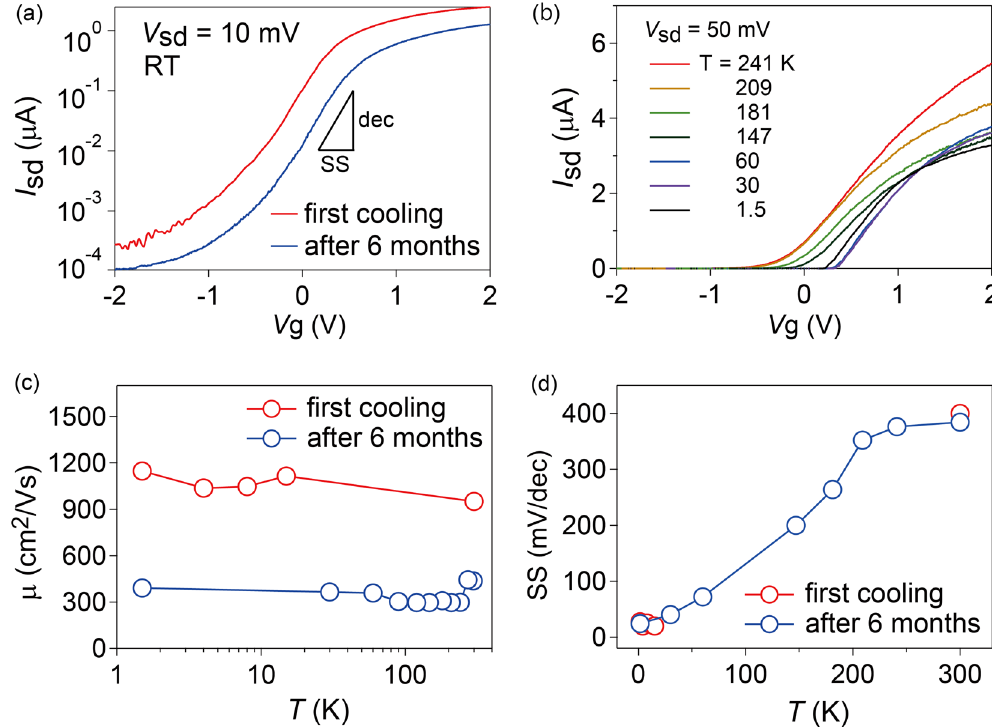
Figure 3. ( a ) Transfer characteristics of the device measured for the first cooling and after several coolings performed over 6 months. The device was stored in ambient conditions for 6 months when not in use. ( b ) Transfer characteristics of the device measured for various temperatures at V sd = 50 mV. ( c ) Field-effect mobility and ( d ) SS values of the device plotted as a function of temperature for the first cooling and for the cooling after 6 months